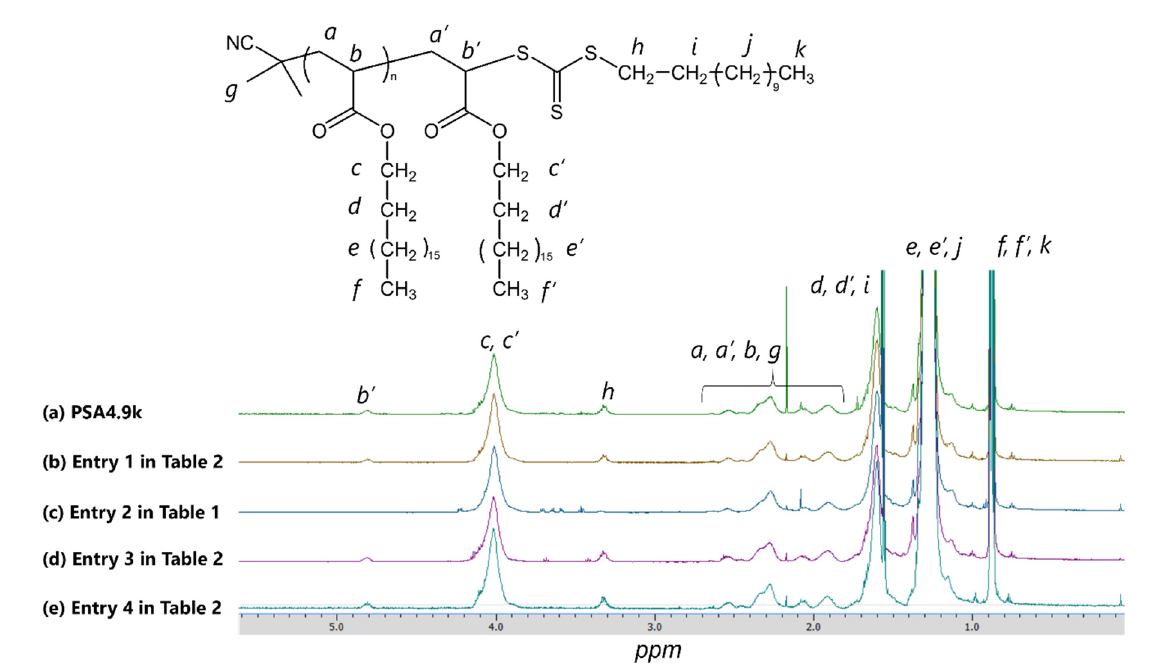
Figure 1. 1 H-NMR spectra for ( a ) RAFT-polymerized PSA 4.9k in Table 1; ( b – e ) TTC removal from PSA 4.9k conducted under various conditions